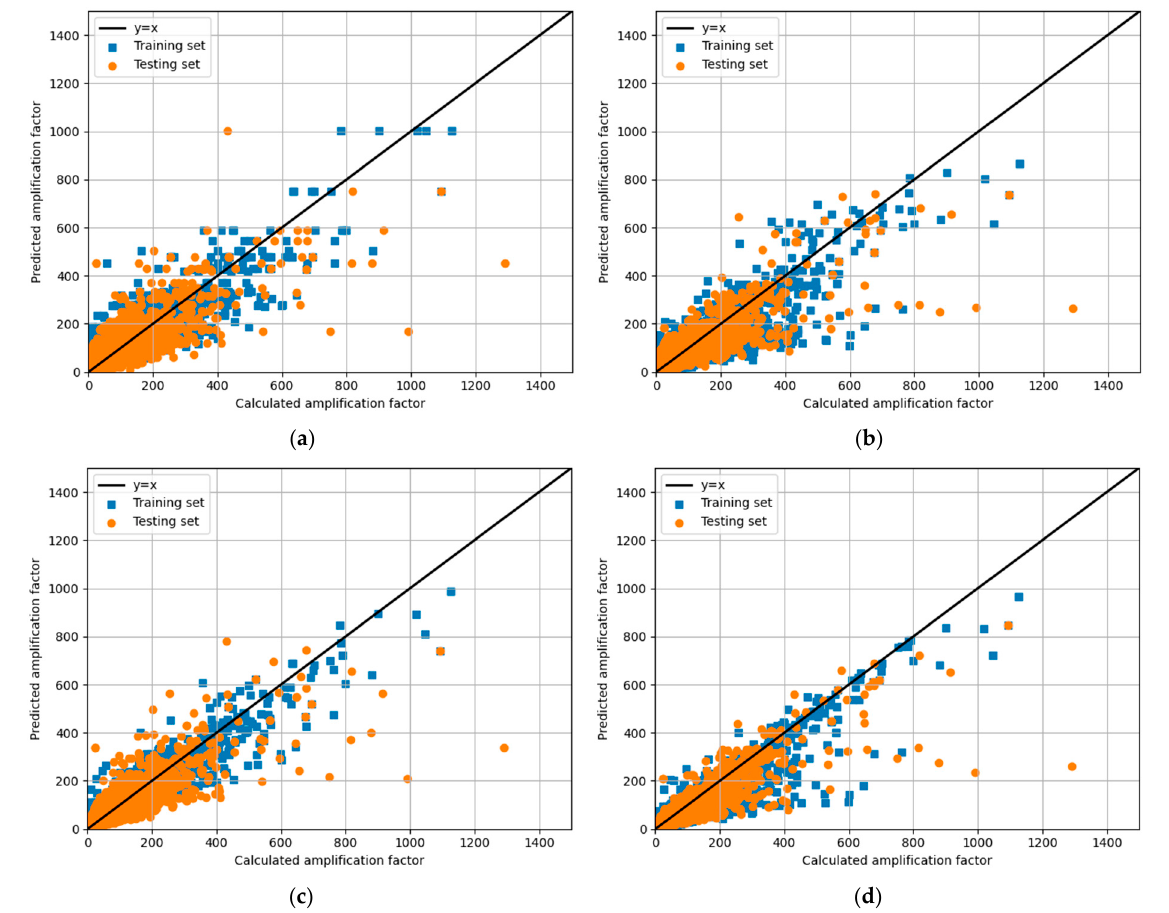
Figure 17. Prediction results of amplification factor using four ML algorithms. ( a ) DT, ( b ) ANN, ( c ) RF, ( d ) GBRT.